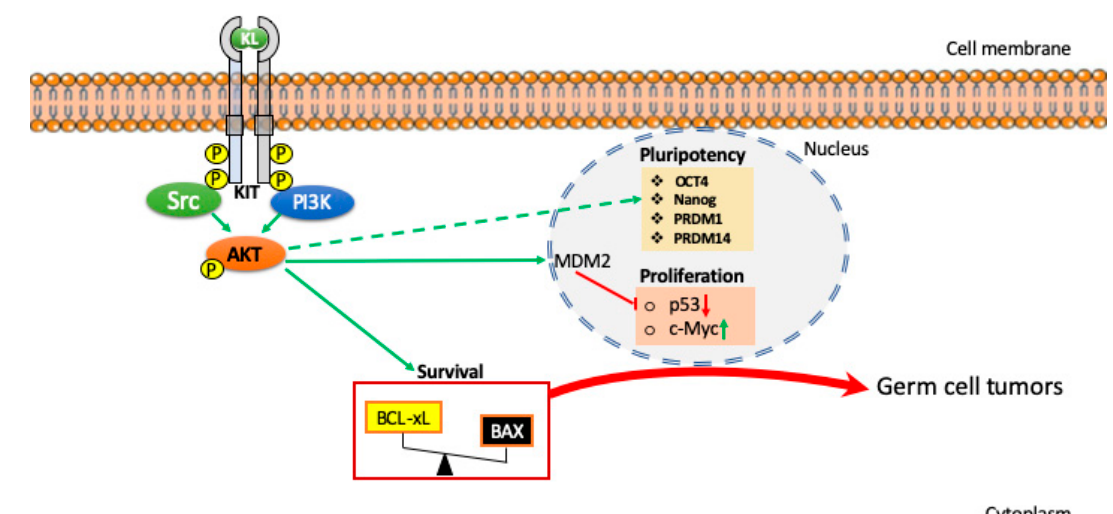
Figure 2. Schematic representation of KL/KIT-dependent PI3K/AKT signaling pathways identified in mouse PGCs involved in their survival/proliferation and possibly in their tumorigenic transformation as described in the text. The role of AKT in sustaining the expression of pluripotency transcription factors is represented as hypothetical (dotted line).